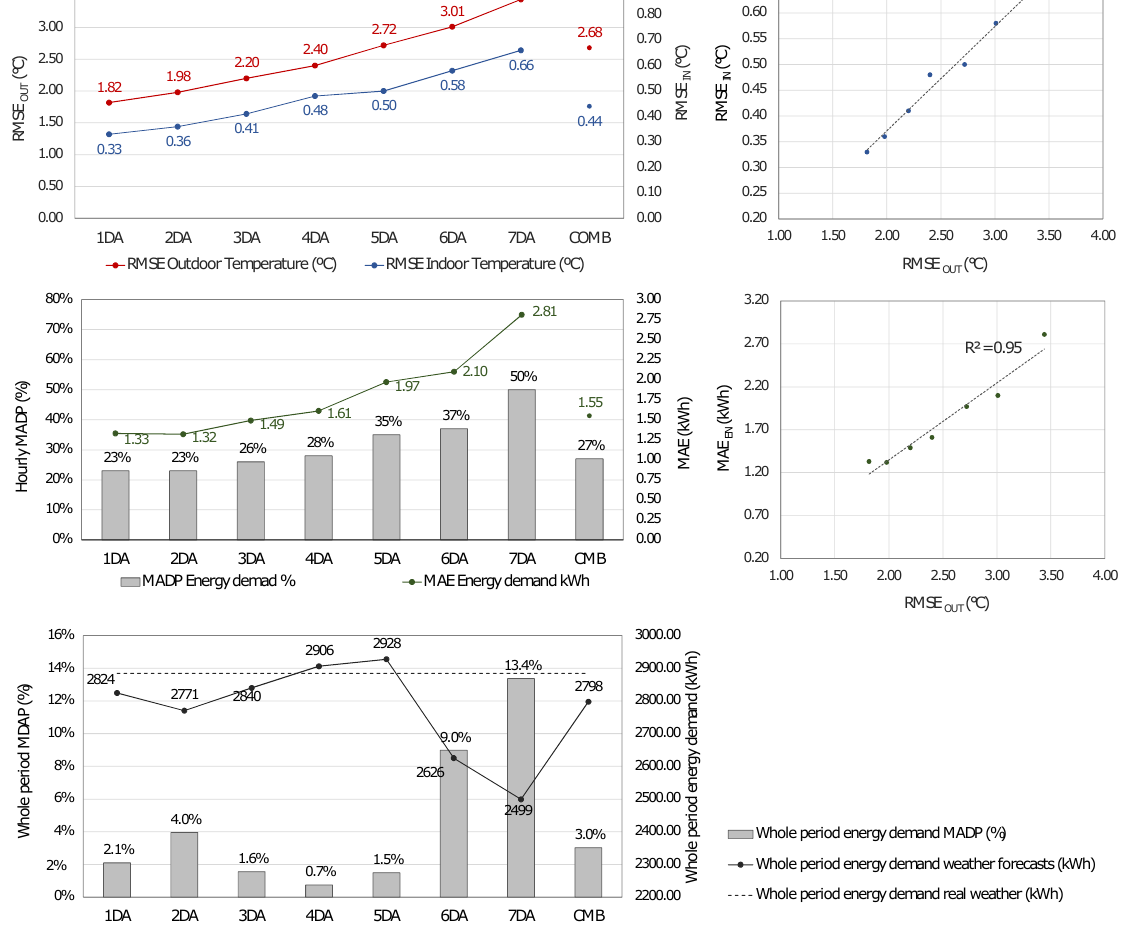
Figure 9. ( above ): comparison between hourly outdoor temperature error ( RMSE ) and hourly mean indoor temperature error ( RMSE ) for the different day-ahead forecasts. ( middle ): MAE and MADP for hourly energy demand for the different day-ahead forecasts. ( below ): MADP and energy demand for the whole period of study for real weather and forecast